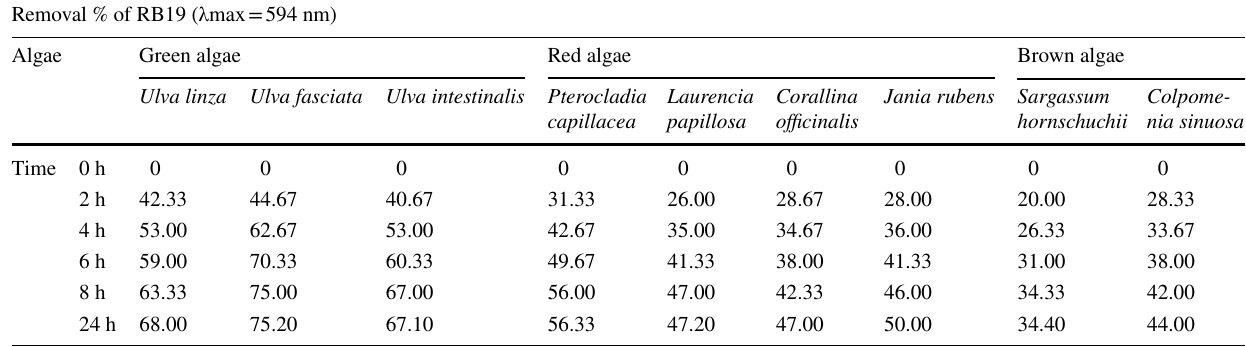
Fig. 4 Removal percentage of Reactive Red 195 by the nine studied fresh algal species